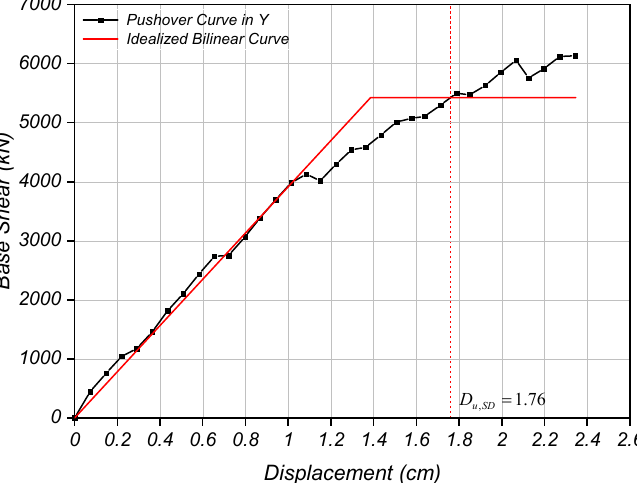
Figure 19. Pushover curve of seismic analysis n.21, direction Y